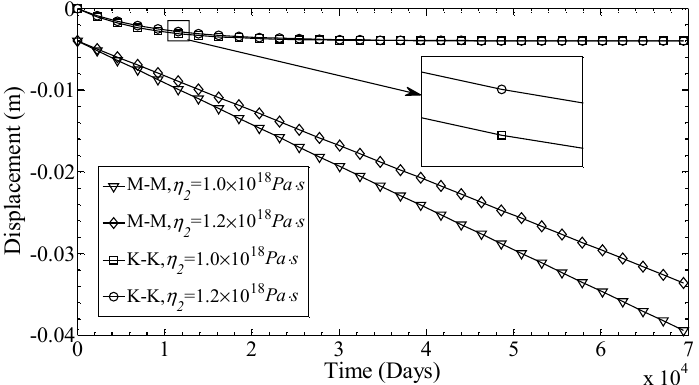
Figure 7. Displacement–time curves obtained from the M–M model and K–K model with different viscosity coefficients of rock mass.